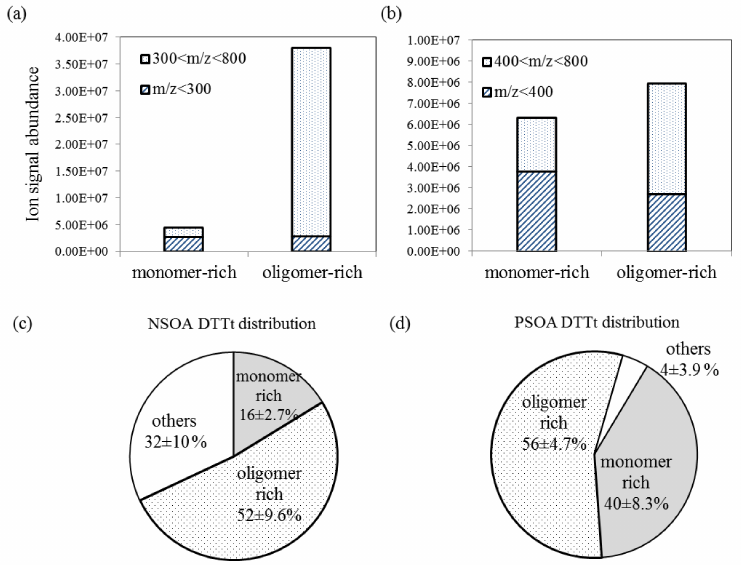
Figure 5. Sum of ion signals for monomers and oligomers in monomer-rich fraction and oligomer-rich fraction for NSOA (a) and PSOA (b) systems. Relative DTT t from monomer-rich fraction and oligomer-rich fraction in NSOA (c) and PSOA (d) systems. The remaining DTT activity (others, white) is attributed to residual SOA fractions that did not clearly elute